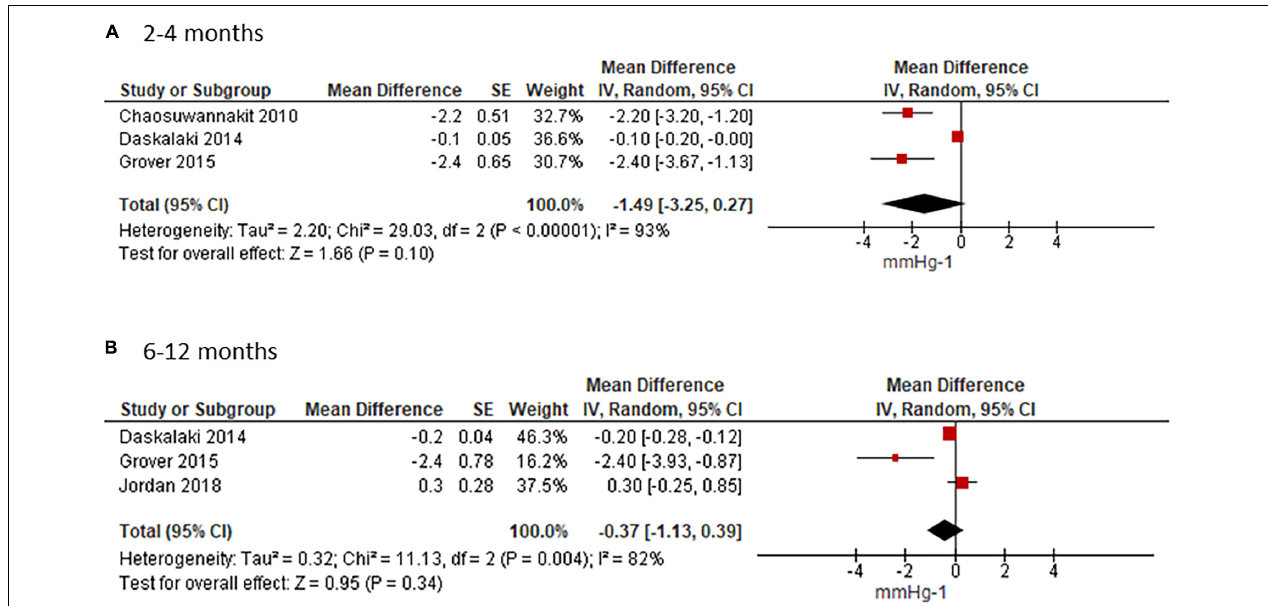
FIGURE 3 | Effect of ANTH-BC on AD. Forest plots illustrating the effect of ANTH-BC on AD divided by time-point of assessment into (A) short-term (3–4 months) and (B) mid-term (6–12 months) effects.